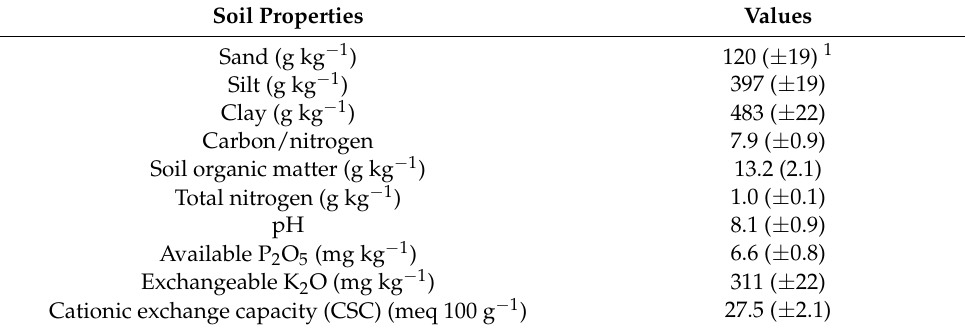
Table 2. Soil properties in the 0–30 cm layer in the experimental plots in 2020.